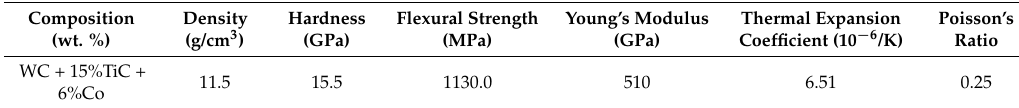
Table 1. Properties of the cemented carbide material.